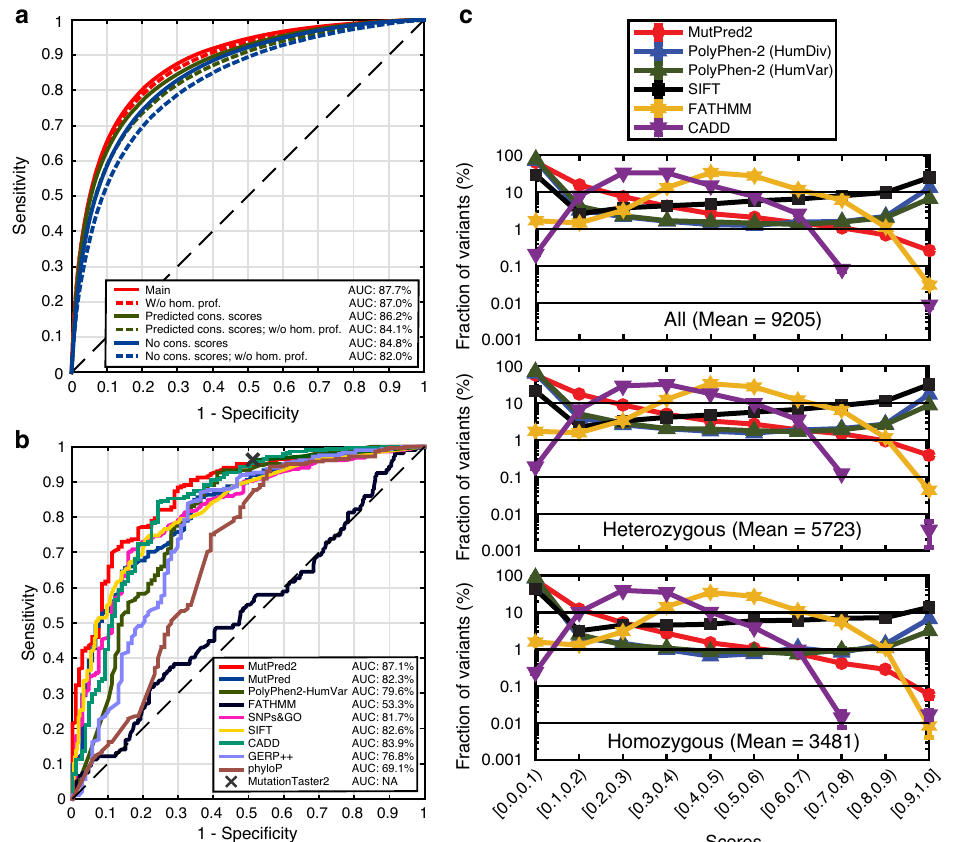
Fig. 2 Performance and interpretability of MutPred2. a ROC curves obtained through tenfold cross-validation on the MutPred2 training set. The main model represents MutPred2 in the default setting (with real conservation scores and homolog count pro fi les). All lines are paired with the solid line representing the model with homolog count pro fi les and the dashed line, representing the model without the pro fi les. b ROC curves on an independent test set, obtained from ClinVar and SwissVar by letting the data accumulate in these databases for 3 years. MutationTaster2 only returns a value of zero or one and therefore its performance is plotted as a single point (X). Since some tools could not assign scores to all variants, results from the subset of the variants (285 pathogenic and 107 benign) that are covered by all methods are shown. Detailed performance measures on this subset and a less stringent set ( fi ltered at 80% sequence identity) are shown in Supplementary Tables 10 and 11. c Mean score distributions for MutPred2, PolyPhen-2 HumDiv, PolyPhen-2 HumVar, SIFT, FATHMM, and CADD applied to ten randomly selected exomes from the 1000 Genomes Project. Error bars represent the standard errors of the means, estimated by dividing the standard deviation in each bin by the square root of 10. All heterozygous and homozygous variants were plotted in separate panels. The mean in each panel represents the average number of variants found in an individual for the given